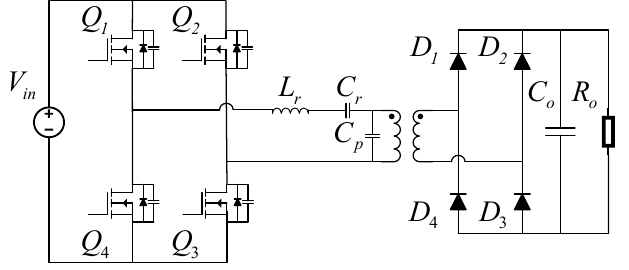
Figure 2. Conventional isolated LCC resonant converter.